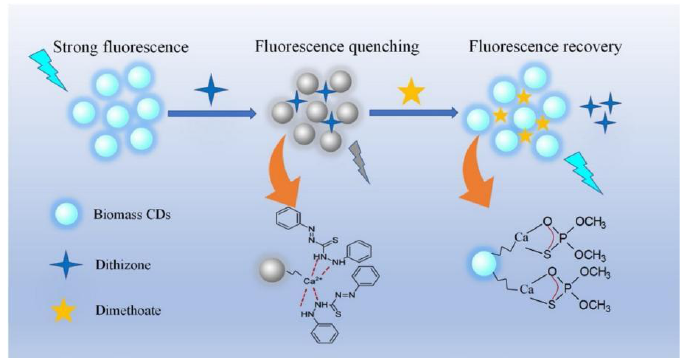
Figure 7. Schematic illustration of the fluorescence switch mechanism for dimethoate detection. Adapted with permission from Liu et al., 2020, copyright 2020. Reproduced with permission from Elsevier [53].